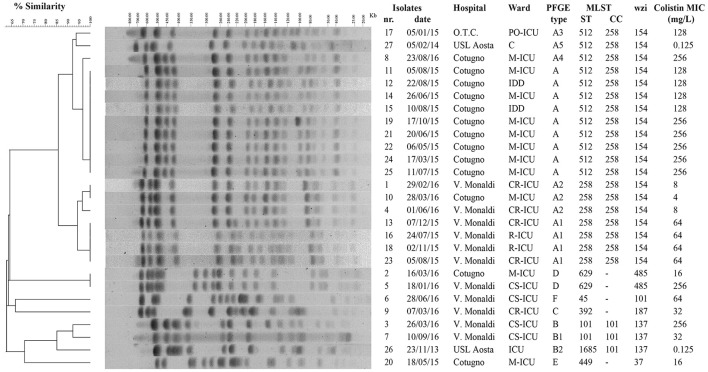
Genotypic analysis of colistin-resistant K. pneumoniae isolates in the HA “Ospedale dei Colli,” Naples. Dendrogram analysis of K. pneumoniae isolates from HA “Ospedale dei Colli,” Naples. Percentage of similarity and sizes in kilobases (kb) of lambda DNA molecular mass markers are indicated. Isolate number, isolation date, hospitals, wards, PFGE type, MLST (ST and CC), wzi gene, and colistin MIC values are also shown. PFGE, pulsed-field gel electrophoresis; MLST, multilocus sequence typing; ST; sequence type; CC, clonal complex.